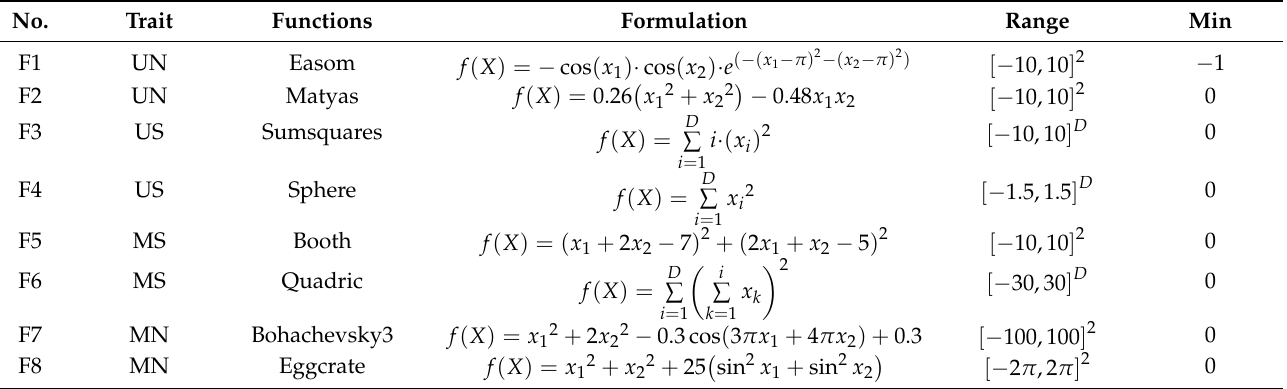
Table 3. Benchmark functions in